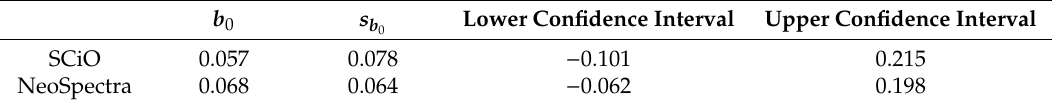
Table 2. Confidence interval for the intercept showing the absence of systematic errors in both PLS models.